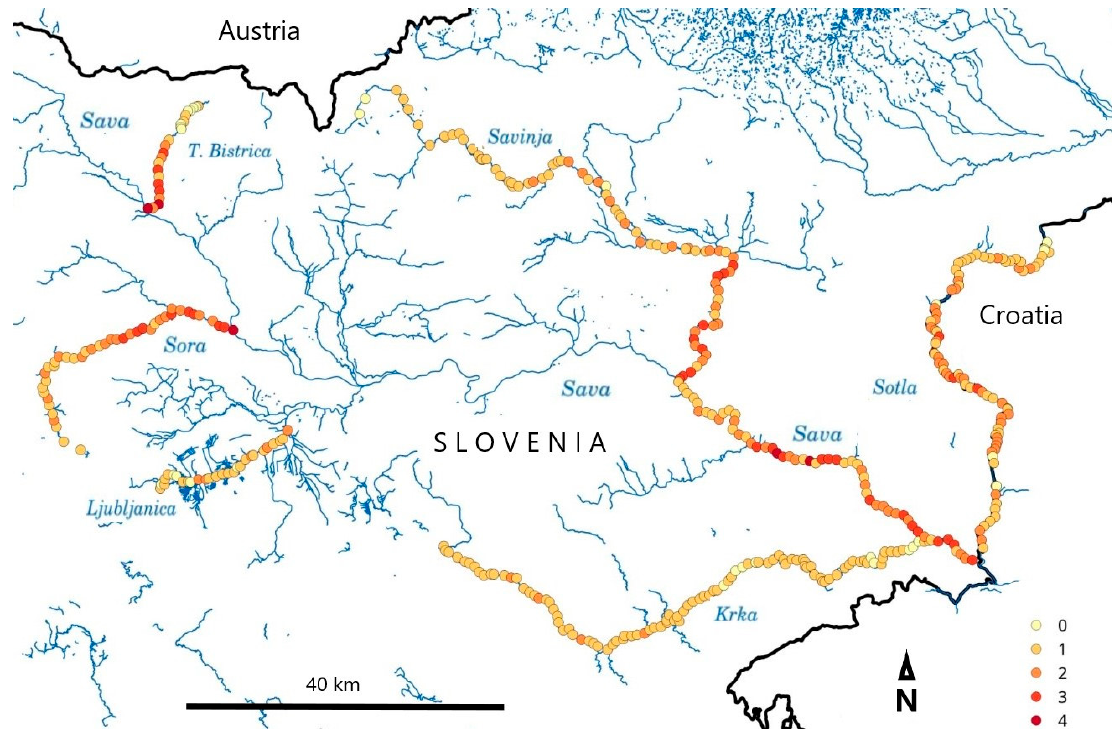
Figure 4. Total abundance for IAS in the individual reaches of the riparian zones analysed along the seven rivers in Slovenia: T. Bistrica, Savinja, Sora, Ljubljanica, Krka, Sotla, and Sava (Key: 1, 1–5; 2, 6–10; 3, 11–15; 4, 16–21) (created with QGIS [50]).